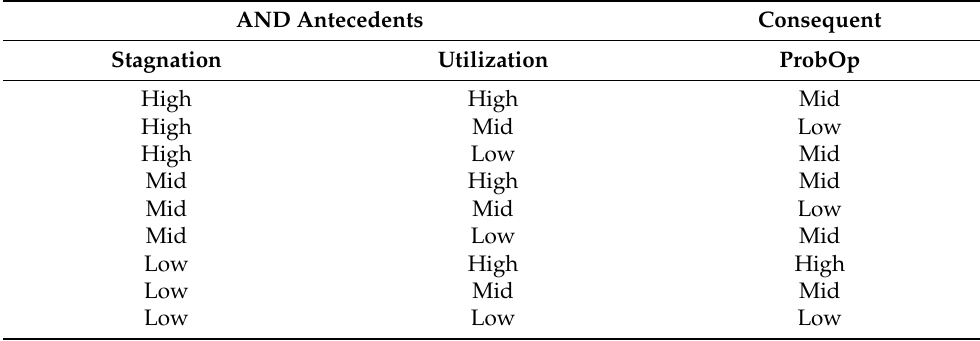
Table 2. Fuzzy controller rules.